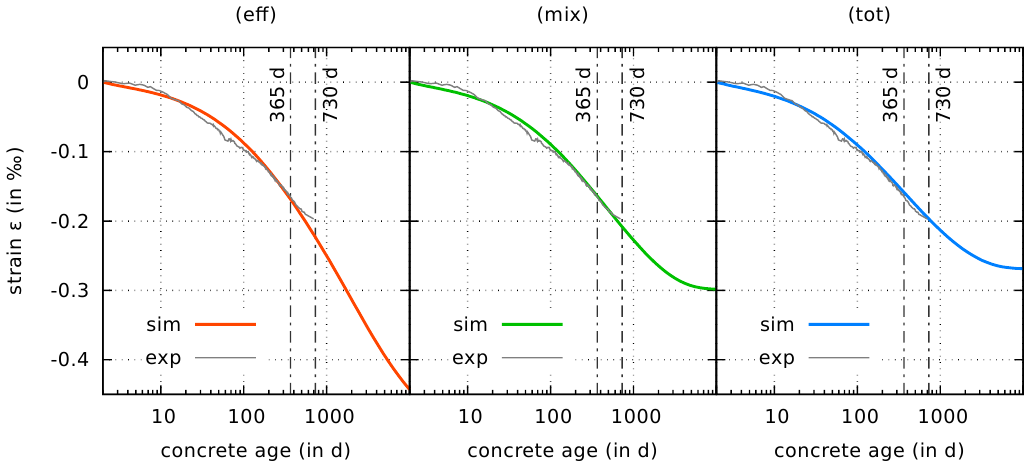
Figure 7. Computed (sim) and measured [8,9] (exp) evolution of the autogenous shrinkage strain based on the effective stress formulation (eff), the mixed stress formulation (mix), and the total stress formulation